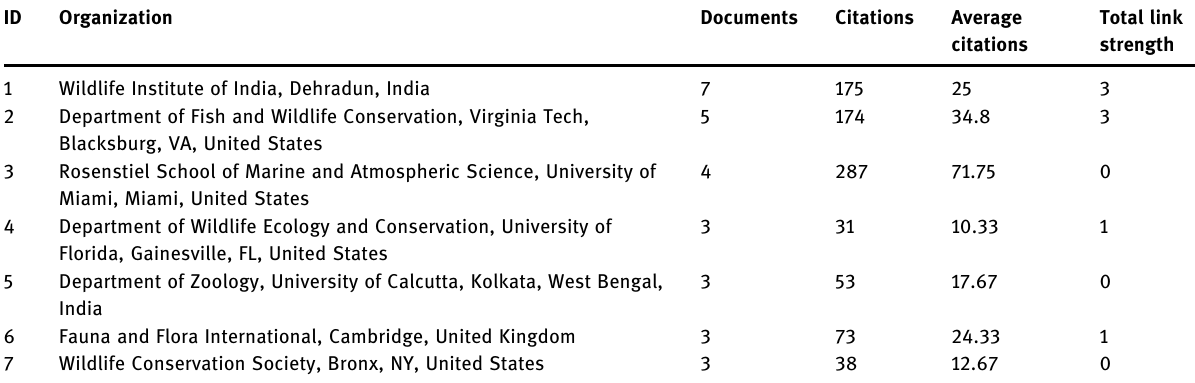
Table 2: Top organizations in Wildlife conservation research studies ID